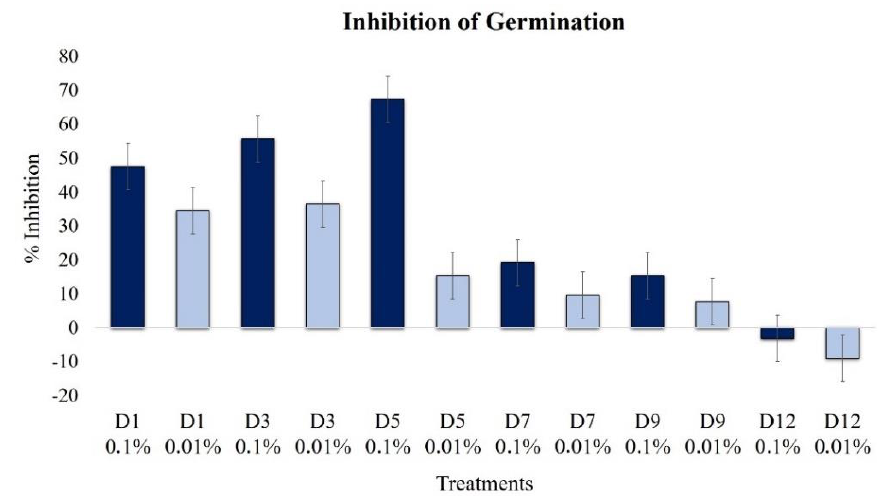
Figure 3. E ff ects of extracts at 0.1% (dark blue bars) and 0.01% (light blue bars) on the germination of conidia of B. cinerea (1 × 10 5 conidia mL –1 at 12 h, 100 rpm, 24 °C).